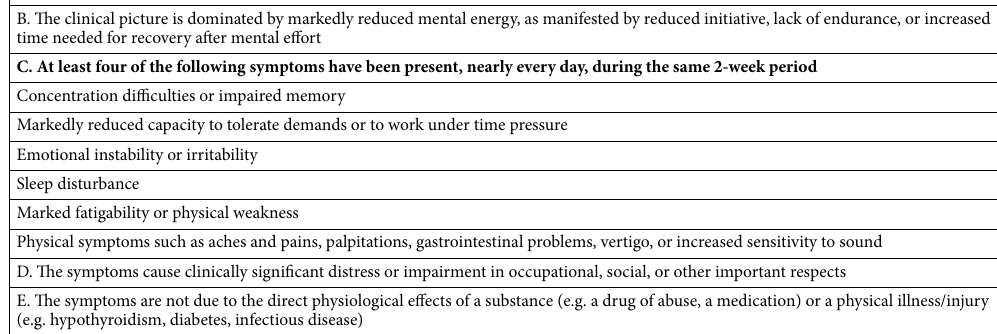
Table 1. Criteria for stress-induced exhaustion disorder according to the Swedish National Board of Health and Welfare and Swedish version of the International Classification of Diseases, 10th edition (code F-43.8). Criteria A through E must be fulfilled to diagnose stress-induced exhaustion